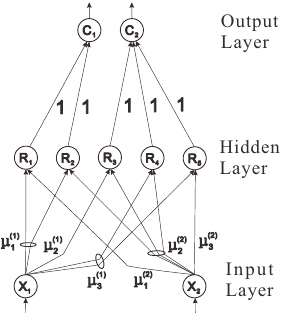
Figure 1. Schematic diagram of a neural network composed of two inputs, five rules, and two outputs developed by Nauck and